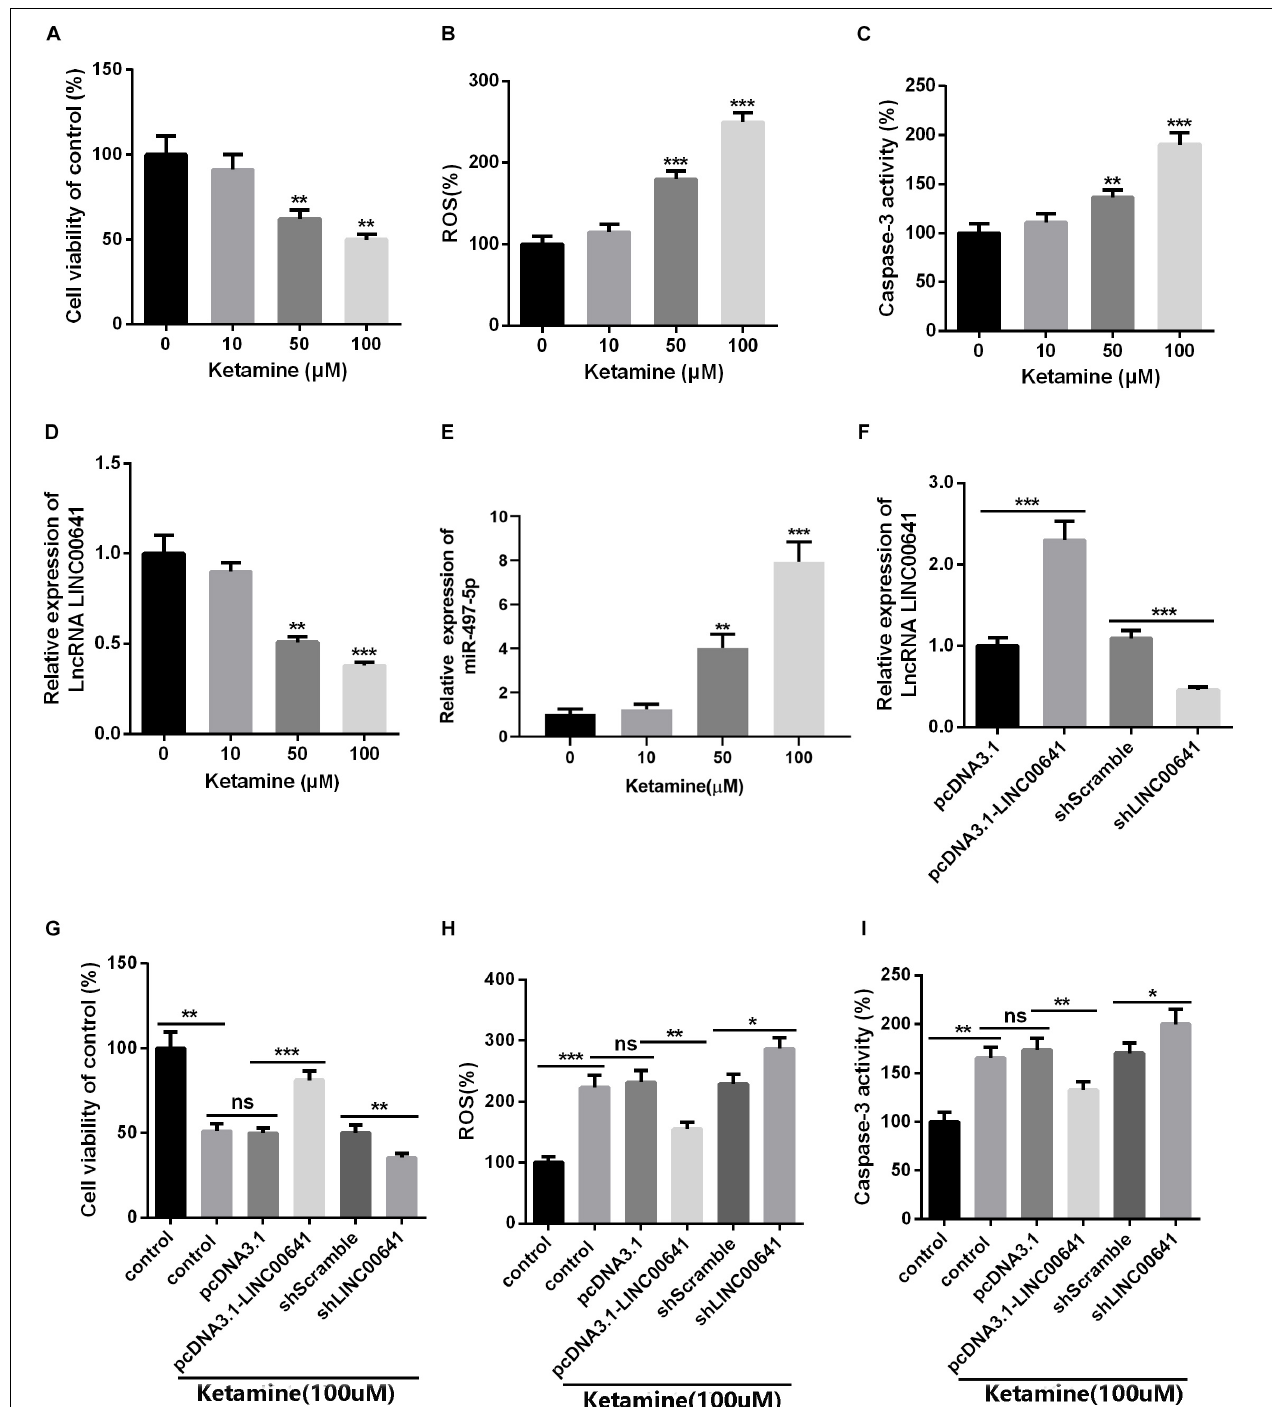
FIGURE 2 | The effect of LINC00641 on ketamine-induced neuronal injury in vitro . Firstly, the neural stem cells treated with different concentrations of ketamine (0, 10, 50, and 100 µ M) in vitro . (A) Cell viability was determined by MTT assay. (B) ROS levels in neural stem cell lines treated with different concentrations of ketamine. (C) caspase-3 activity was determined. (D,E) qRT-PCR was used to analyze the relative expression of LINC00641 and miR-497-5p in neural stem cell lines; ** P < 0.01 and *** P < 0.001 compared with 0 mg/kg group. Then the neural stem cells were under 100 µ M ketamine treatment and the shLINC00641 or pcDNA3.1. (F) The relative expression of LINC00641 in LINC00641 cell line (pcDNA3.1-LINC00641) and silencing cell line (shLINC00641) was analyzed by qRT-PCR. (G–I) The cell viability, ROS level and caspase-3 activity of neural stem cells in LINC00641 cell line and silencing cell line (shLINC00641) were measured. ns. P > 0.05, * P < 0.05, ** P < 0.01, and *** P < 0.001.